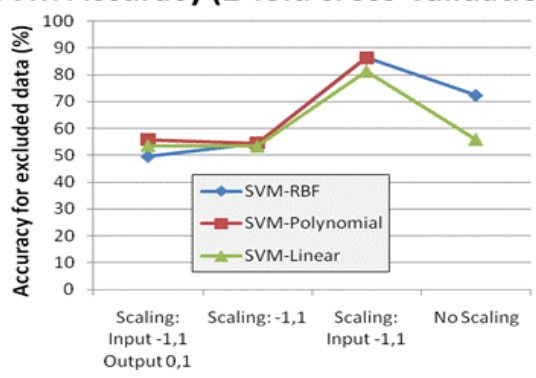
Fig. 4: SVM Accuracy for Unknown Environments